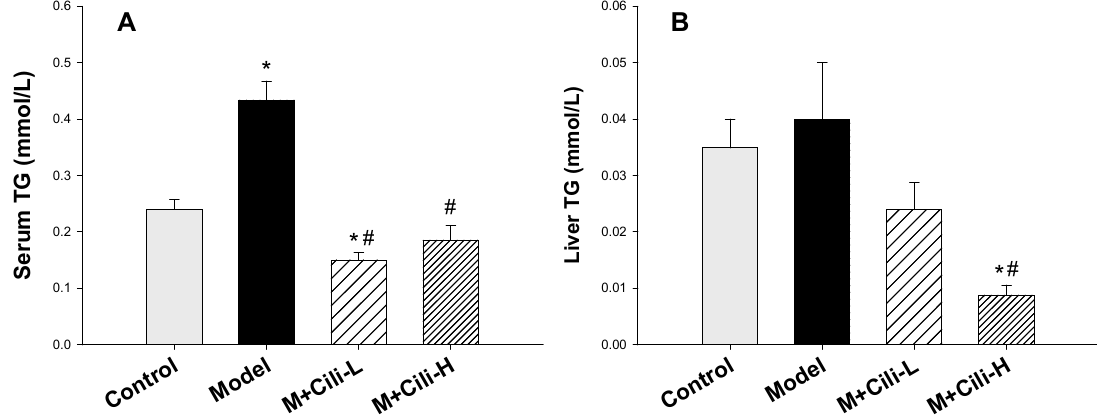
Figure 3. Serum triglyceride (Serum TG, ( A )) and liver triglyceride (Liver TG, ( B )) determination. Data are mean ± SEM ( n = 9–11), * Significantly different from the Control group, p < 0.05; # Significantly different from the Model group, p < 0.05.